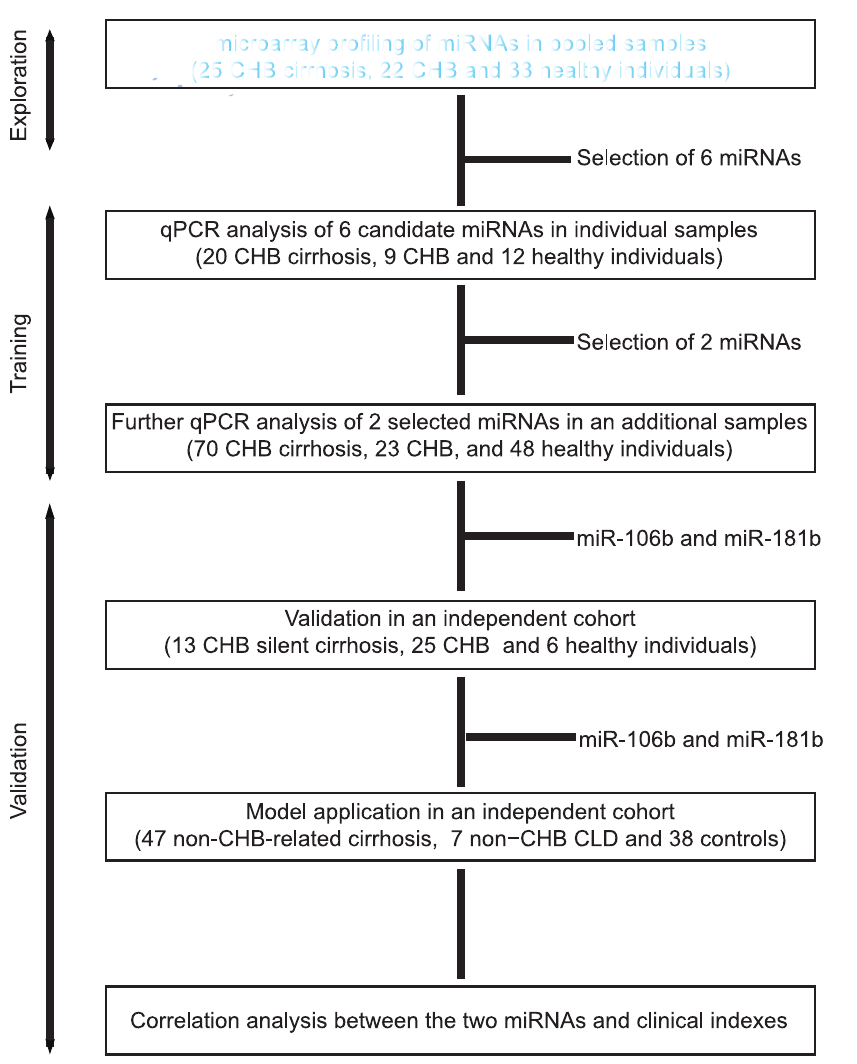
Figure 1. Overview of the design strategy. This study was divided into three phases: exploration, training and validation phase. CHB, chronic hepatitis B; CHB cirrhosis, CHB-related cirrhosis; non 2 CHB CLD, non 2 CHB-related chronic liver disease; qPCR, quantitative real-time PCR.